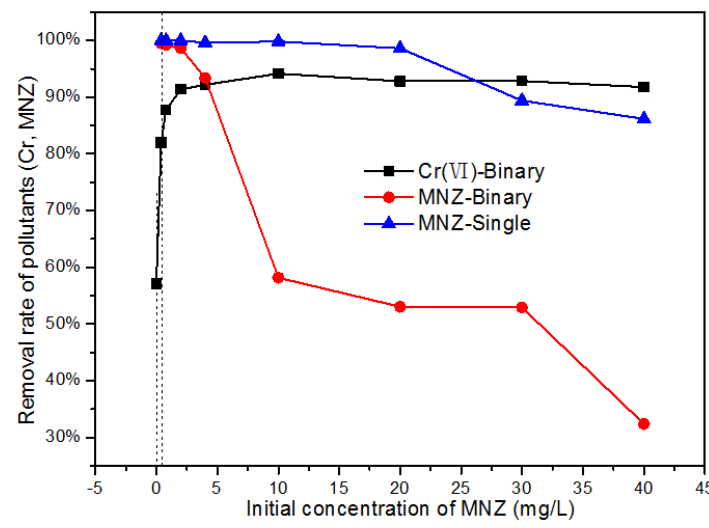
Figure 10. Photocatalytic treatment of Cr(VI) and MNZ in single and binary pollutant system.